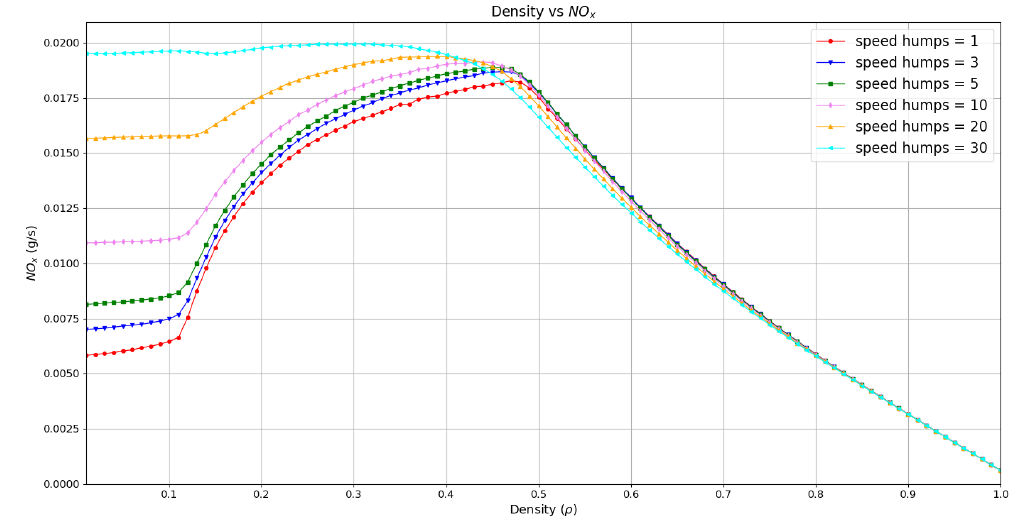
Figure 9. NO x instant emissions as a function of